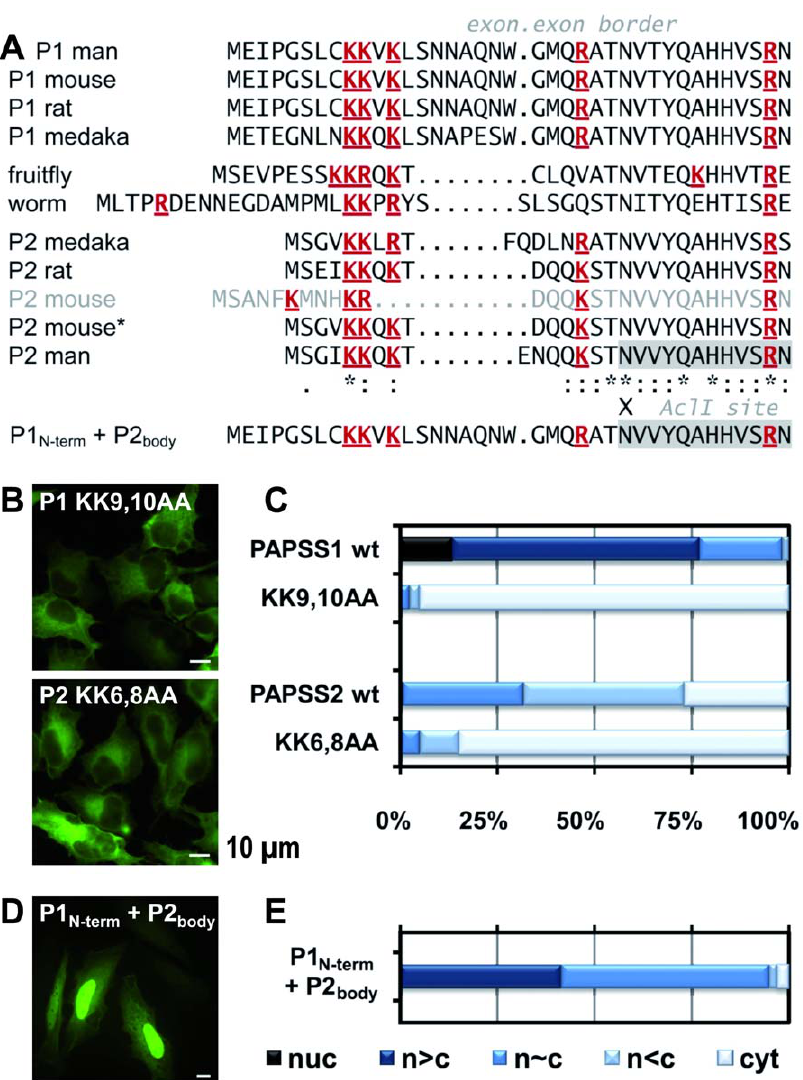
Figure 6. A conserved NLS within the N-terminus of PAPS synthases. A , alignment of the N-terminal protein sequence of PAPS synthases from several organisms. PAPS synthase N-termini were aligned with regard to their conserved N-terminal KKxK motif and the beginning of the conserved sequence of the globular APS kinase domain. Although this motif should be regarded as K(K/R)x(K/R) only due to the sequences from fruitfly and worm, we adhere to KKxK in the text for simplicity. All positively charged amino acids are written in red and underlined. An exon-exon border is indicated for all sequences derived from Ensembl. For mouse PAPS synthase 2 an alternative N-terminal sequence, P2 mouse*, is given that is supported by 14 different EST sequences. The sequence for the swapping construct of the PAPSS1 N-terminal sequence and the remaining part (body) of PAPSS2 is given below. Sequences used: human PAPSS1 (P1) [RefSeq: NM_005443], mouse P1 [RefSeq: NM_011863], rat P1 [RefSeq: NM_001106471], medaka P1 [Ensembl: ENSORLP00000008587], splice form RA from Drosophila melanogaster [FlyBase: FBgn0020389], the PPS-1 protein from C. elegans [RefSeq: NM_069456/Wormbase: T14G10.1], medaka P2 [Ensembl: ENSORLG00000006251], rat P2 [RefSeq: NM_001106375], mouse P2 [RefSeq: NM_011864 .3 ], mouse P2* ( Information S1 ) and human PAPSS2B [RefSeq: NM_001015880]. B , HeLa cells expressing PAPS synthase point mutants within the conserved KKxK motif as EGFP fusions. All samples were fixed after 24 h expression. C , quantitative evaluation of mutants shown in B and comparison to the wild-type proteins PAPSS1-EGFP and PAPSS2-EGFP. D and E , a swapping construct with the N-terminal sequence of PAPSS1 and the PAPSS2-EGFP body expressed in HeLa cells shows clear nuclear accumulation relative to the PAPSS2-EGFP wild type.